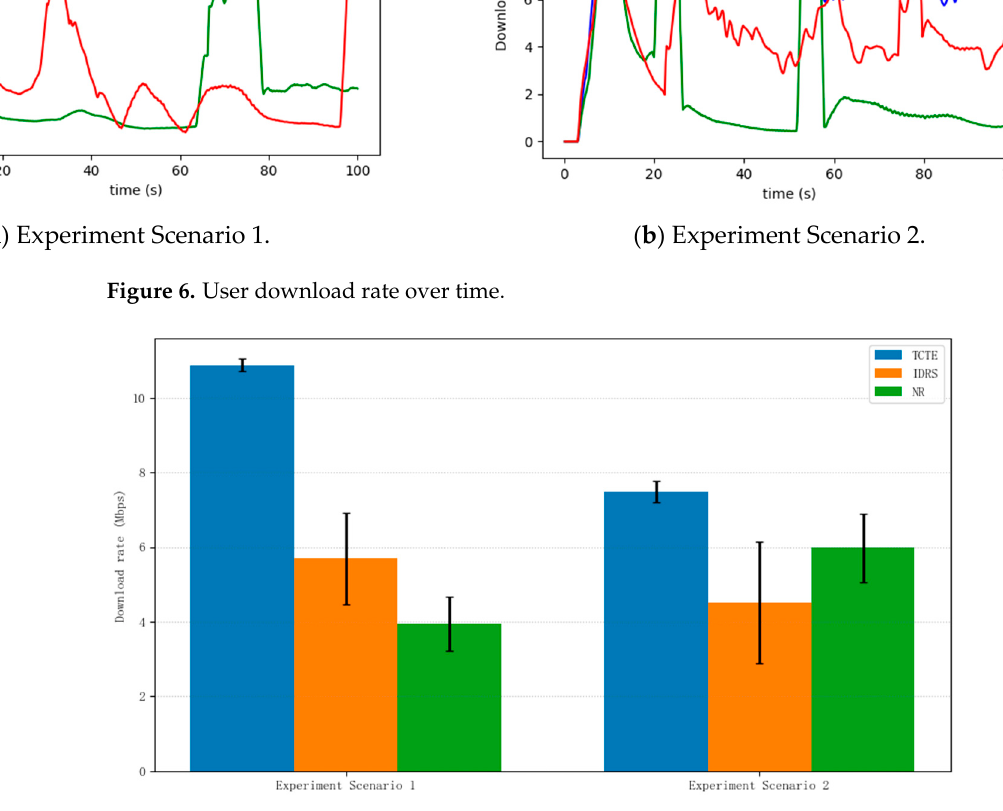
Figure 7. Mean and con fi dence intervals for download rates.